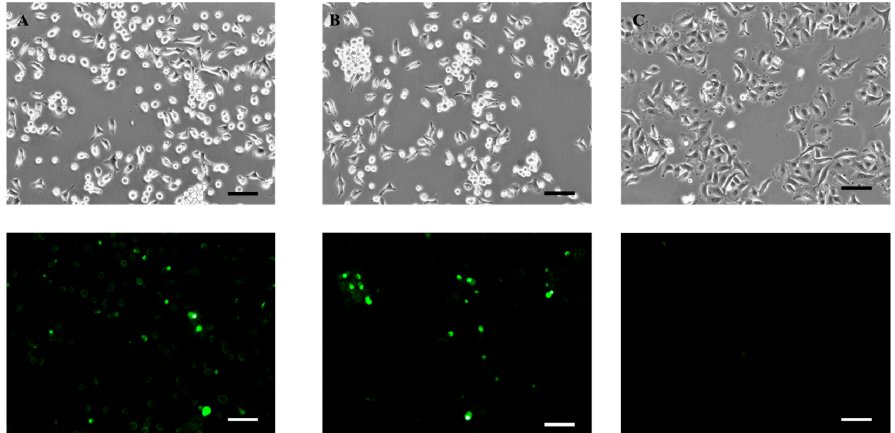
Figure 8. Phase-contrast images of A549 cells treated with ( A ) AITC, ( B ) SIN+MYR, and ( C ) DMSO (top panel), and fluorescence images were taken with the Caspase-3/7 green detection reagent (bottom panel). The fluorescent cells confirm the Caspase-3/7 activation, and no fluorescence was detected in the cells treated with DMSO as the control group (scale bar = 100 µ